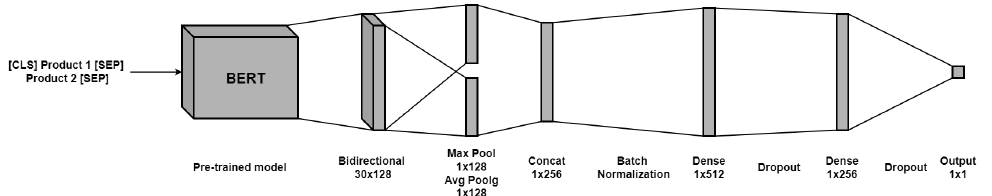
Figure 7. BERT-based architecture for textual descriptions of